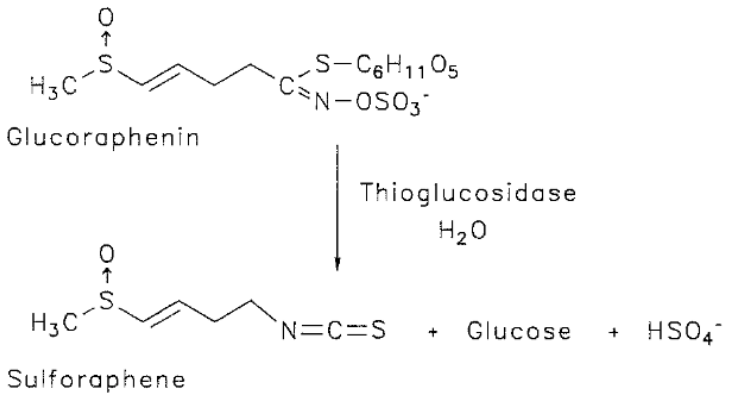
Figure 1. Enzymatic hydrolysis of glucoraphenin to sulforaphene. Adapted from Brinker and Spencer [17].